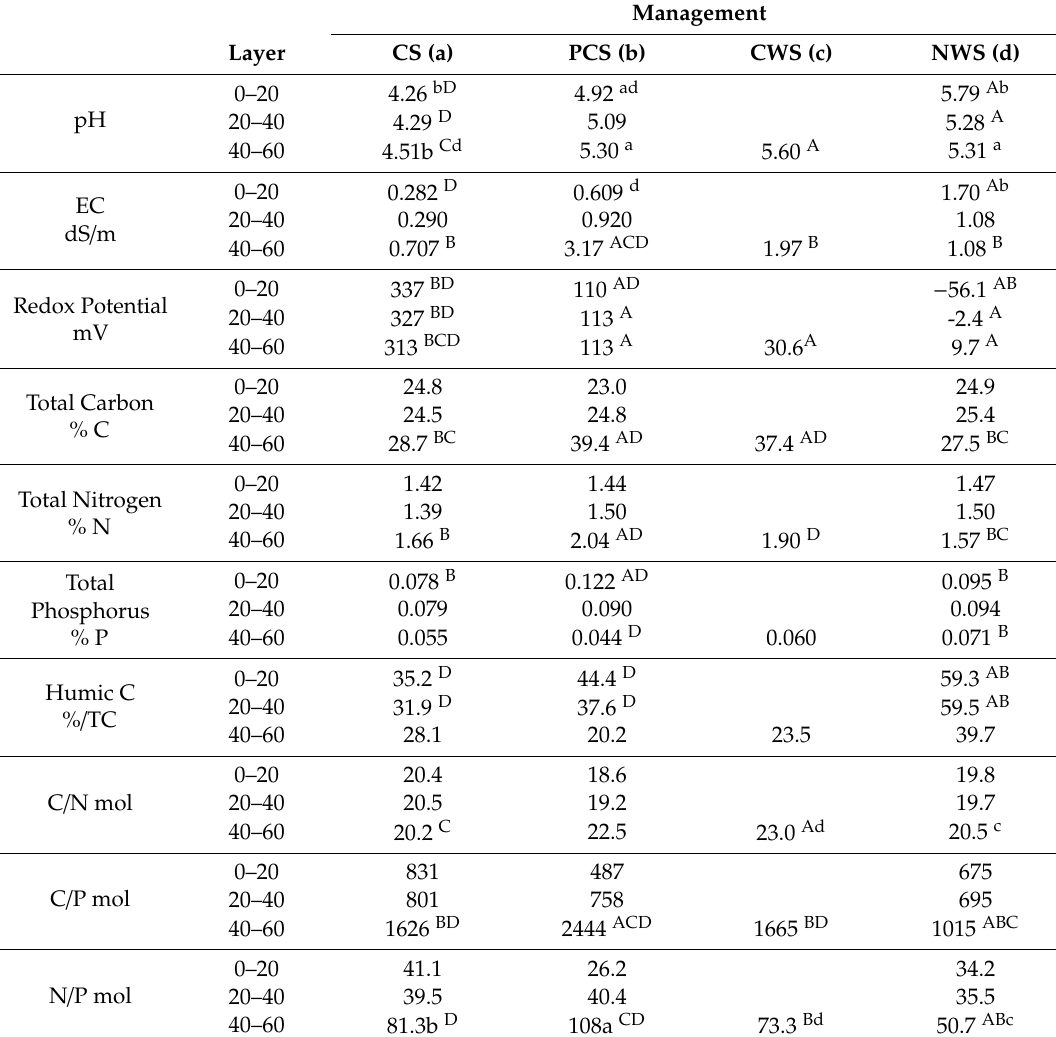
Table 2. ANOVA of main physicochemical properties and the molar ratios between the main macronutrients. Statistically significant di ff erences between the respective sites and depths are indicated by superscript indices that denote the significantly di ff erent site: a = CS; b = PCS; c = CWS; d = NWS. Statistically significant di ff erences, with p < 0.01, are indicated by uppercase letters and those with 0.01 < p < 0.05 are indicated by lowercase